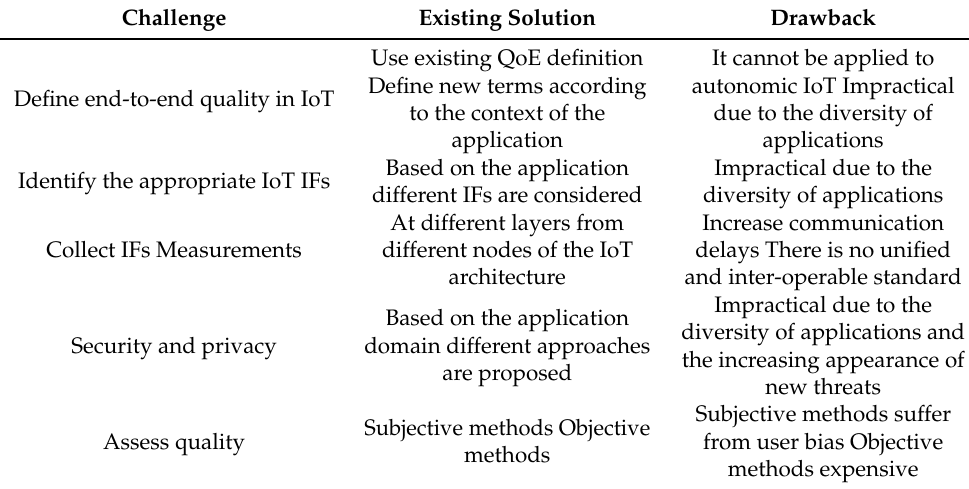
Table 7 overviews the challenges concerning quality in IoT. Table 7. Quality challenges in